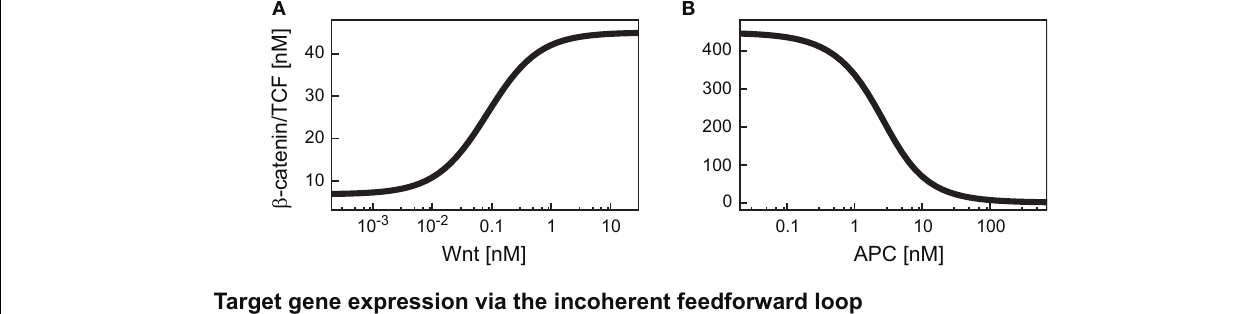
FIGURE 4 | Expression levels of differentially regulated target genes in aWnt or anAPC concentration gradient. (A,B) β -Catenin/TCF steady states within theWnt or the APC concentration gradient. (C–H) Steady state concentrations of target